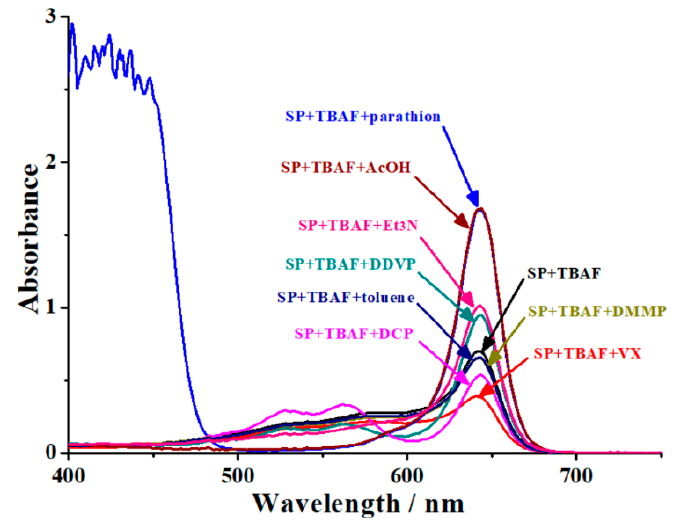
Figure 5. UV − Vis spectra changes in colorimetric solutions after the addition of different interferents.